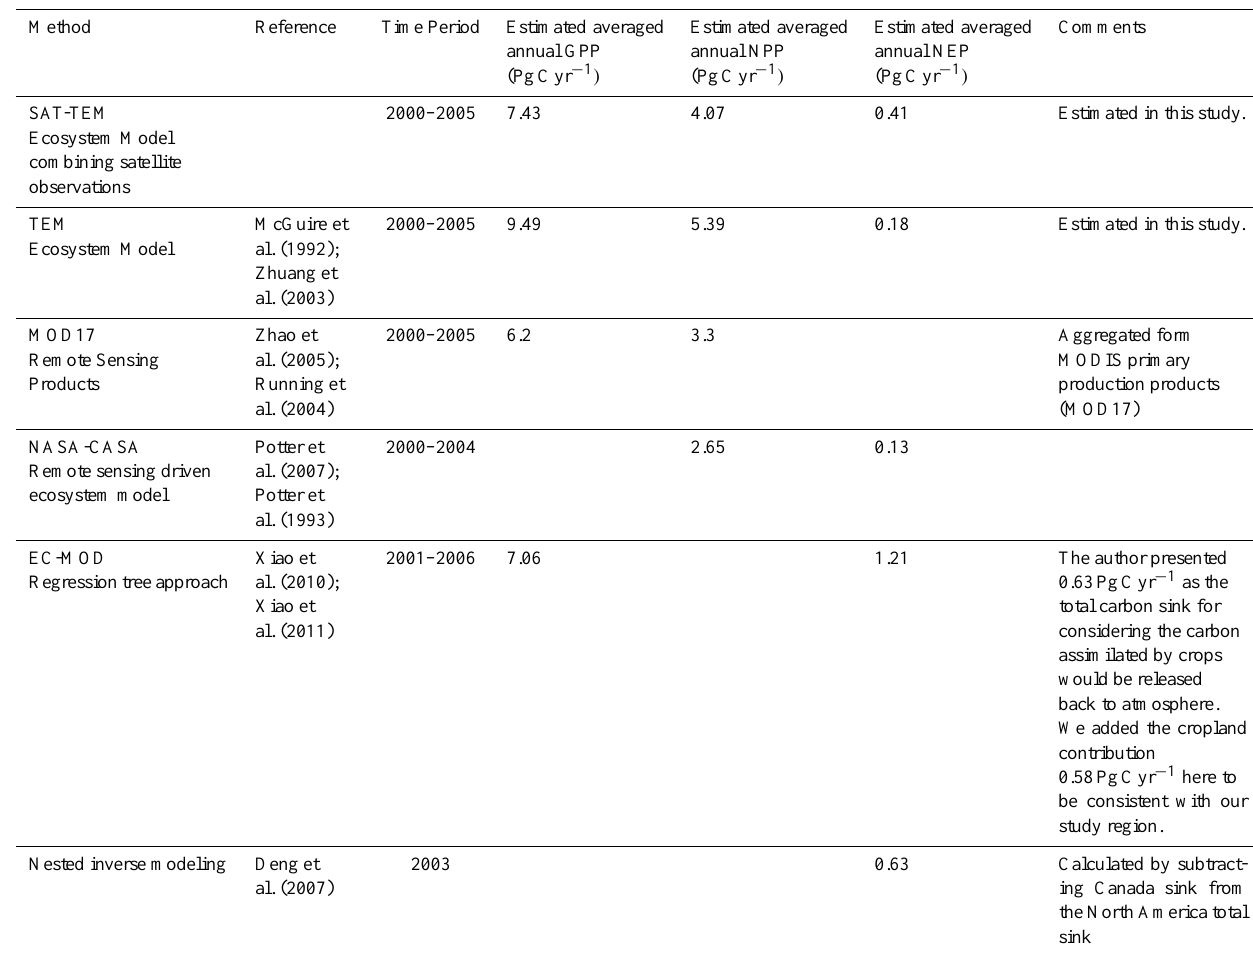
Table 7. Comparison of carbon fluxes between TEM estimated and other existing estimates in the conterminous United